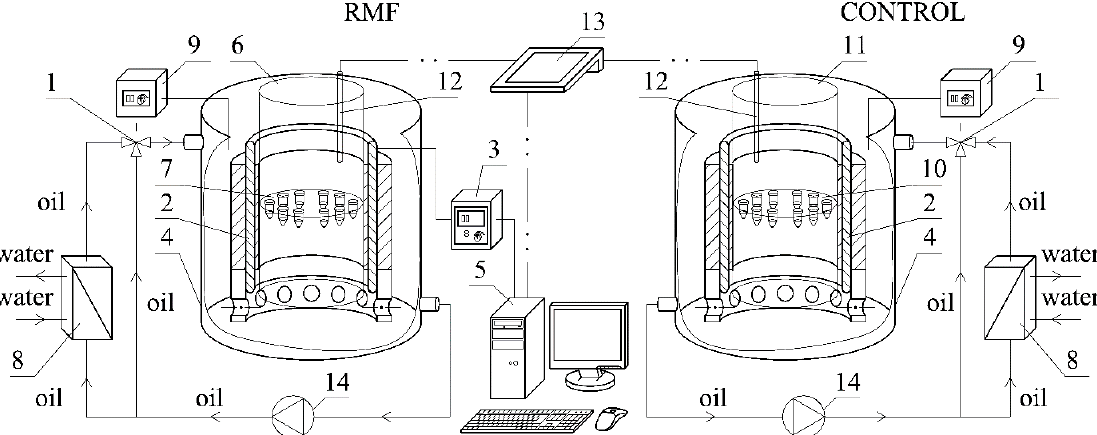
Figure 1. Experimental set-up: 1—cooling system; 2—RMF generator; 3—ac transistorized inverter;